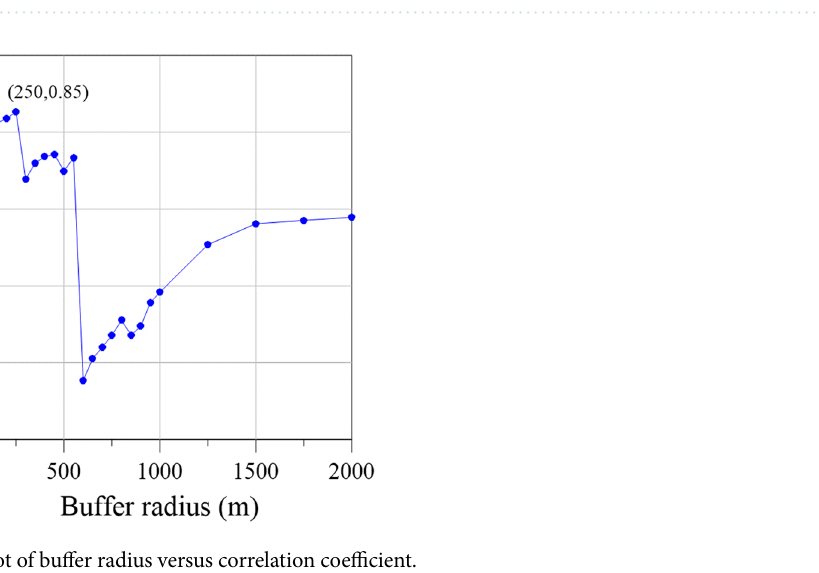
Figure 3. Distribution of managed wells in Yunlin County. This figure was created using ArcGIS 10.6.1 software.